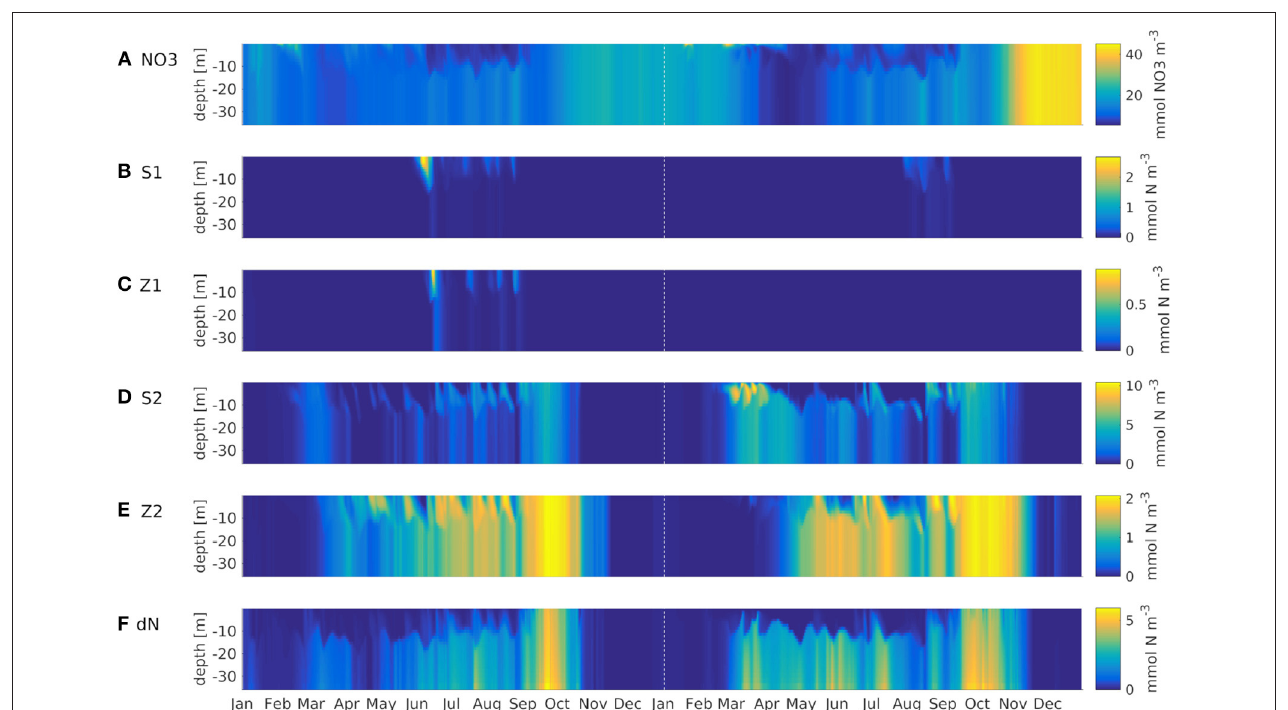
FIGURE 4 | Hovmöller diagrams of ROMS-CoSiNE simulations using the IND scheme at the station marked by the black cross in Figure 1 . In top down order, the panels are NO3 ( mmolNO 3 m − 3 ) (A) , small phytoplankton (B) , microzooplankton (C) , diatoms (D) , mesozooplankton (E) and nitrogenous detritus (F) (all mmolNm − 3 ). The dashed vertical line marks the first of January